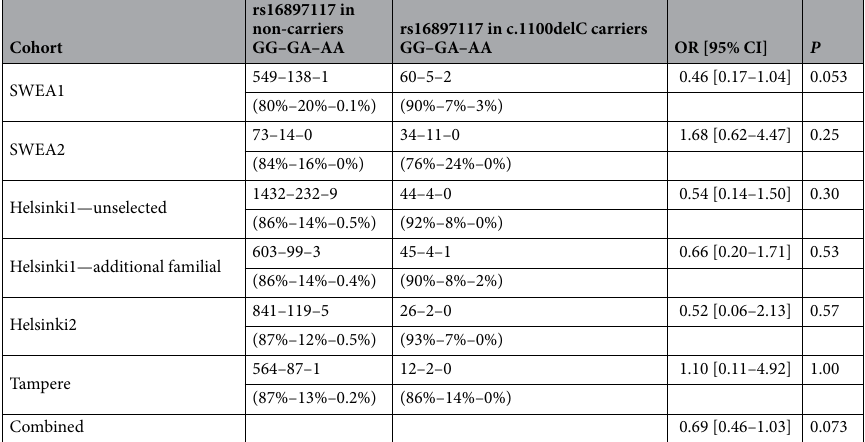
Table 1. Rs16897117 association with CHEK2 :c.1100delC in a case-only analysis.